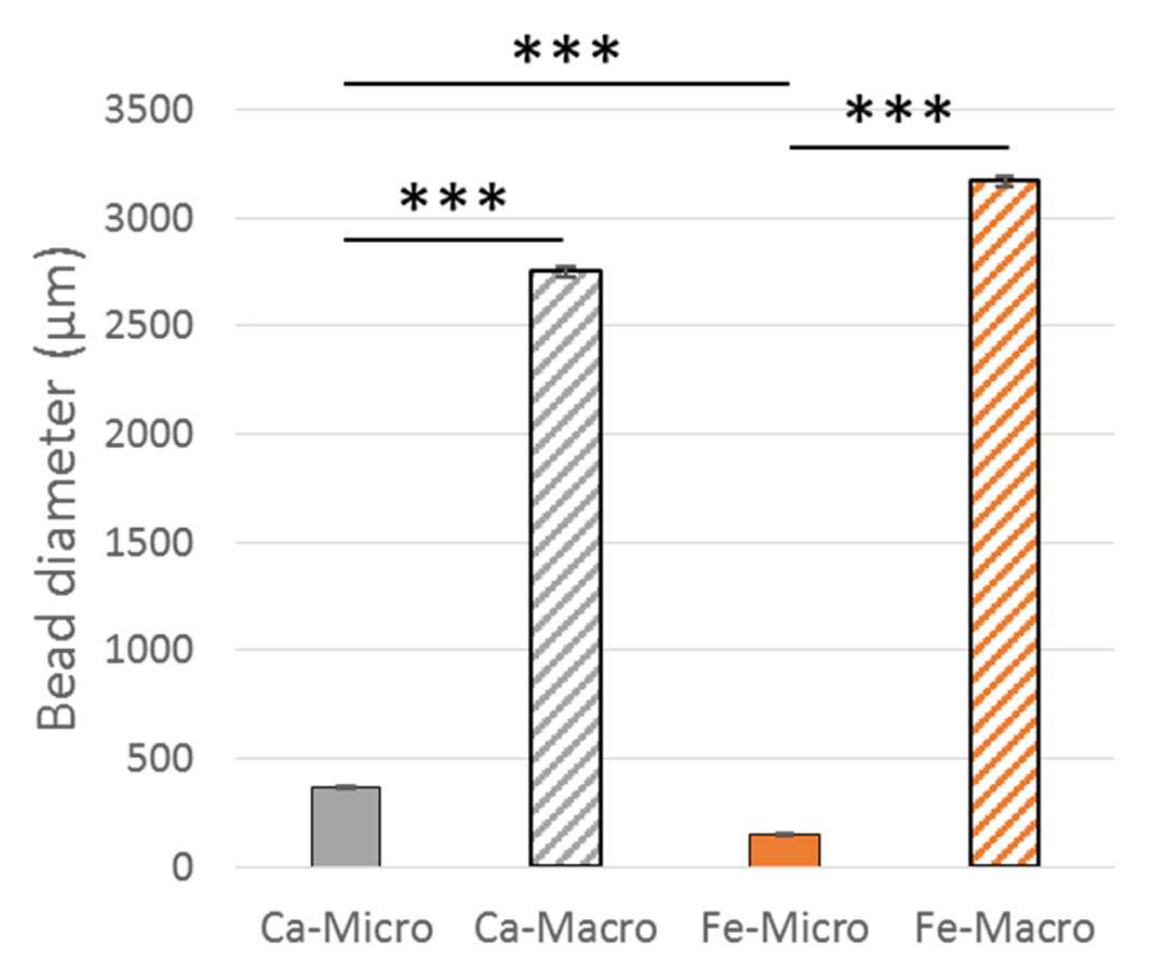
Figure 6. Bead diameter of the different groups. Mean and standard error of mean. *** p < 0.001.